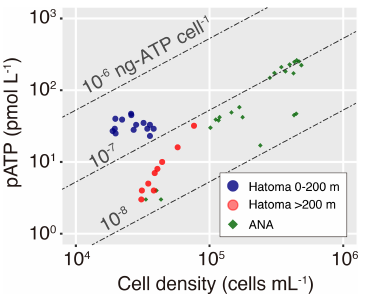
Figure 4. A cross plot between pATP concentration and total cell density. Symbols are the same as those in Fig. 3. Dashed diagonal lines represent cellular ATP